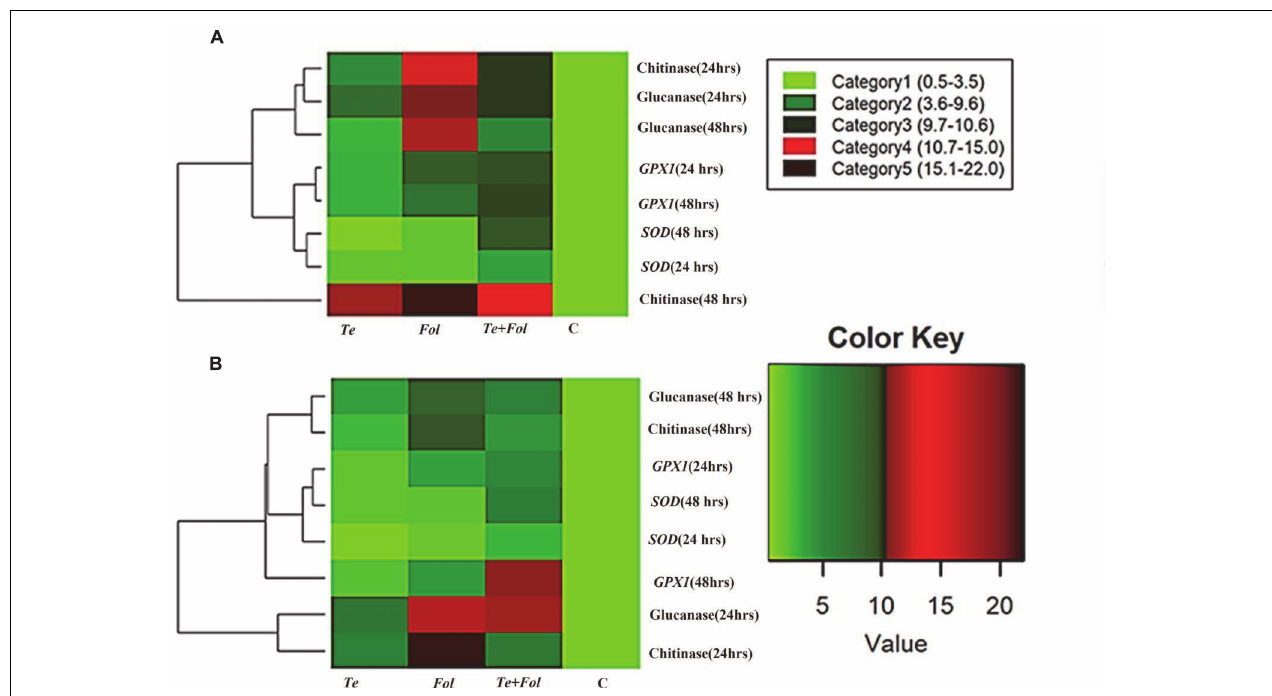
FIGURE 8 | Heat map and clustering analysis of PR proteins and antioxidative defense genes in tomato. The rows represent the expression profile of defense related antioxidative genes and those encoding for PR proteins (chitinase and glucanase) that were expressed in a time-dependent and tissue-specific manner while the treatments are shown as columns. The row dendrogram represents the gene clusters with similar pattern. (A) The heat map showing the expression profile changes of the genes encoding for the PR proteins (chitinases and the glucanases) and antioxidative enzymes including SOD and SlGPX1 in each of the four different treatments at 0, 24, and 48 h in the root tissues. (B) The heat map showing the expression profile changes at 0, 24, and 48 h in leaf